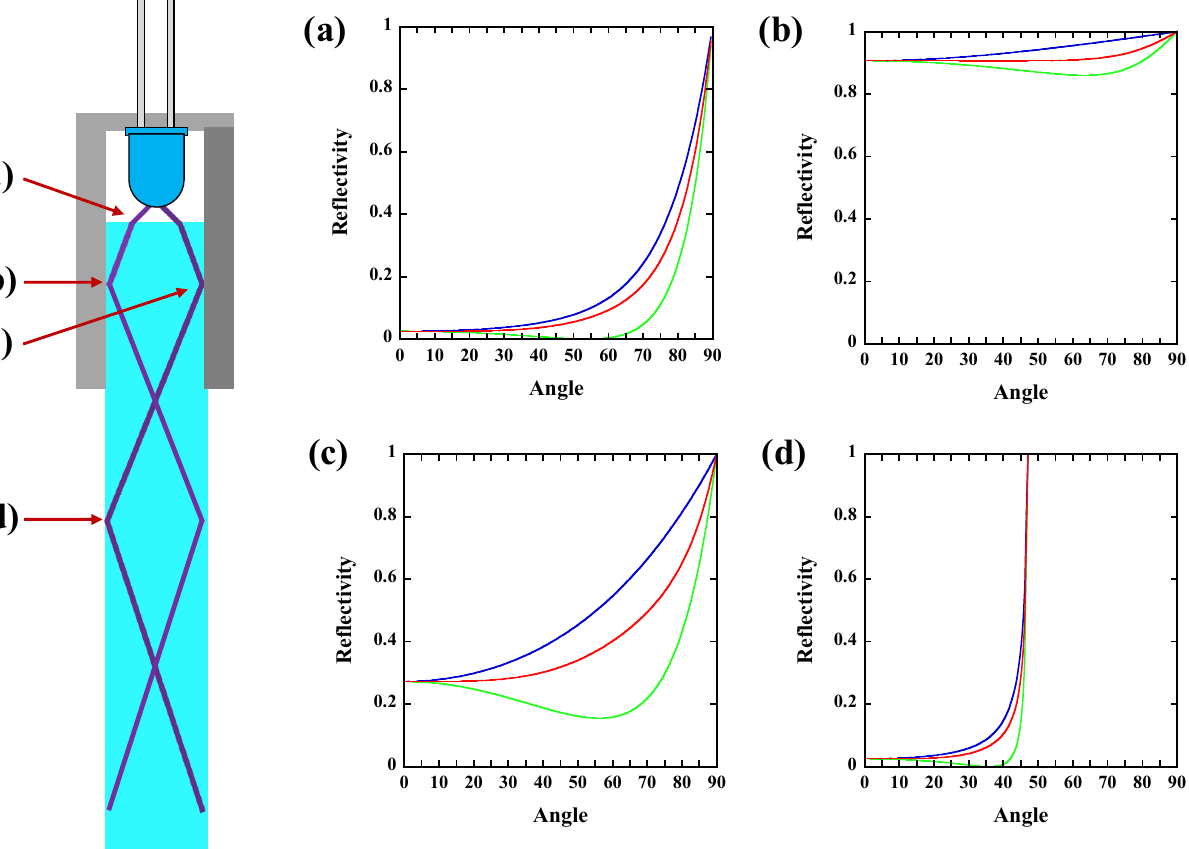
Figure 6. Reflectivity versus incident angle for 265 nm DUV light at the interfaces ( a – d ) of the WW region. ( a ) air/water interface, ( b ) Al-surface/water interface, ( c ) Fe-surface/water interface, and ( d ) water/air interface. The blue line shows the s-polarized light (perpendicular to the plane of incidence), the green line shows the p-polarized light (parallel to the plane of incidence), and the red line shows the unpolarized light.